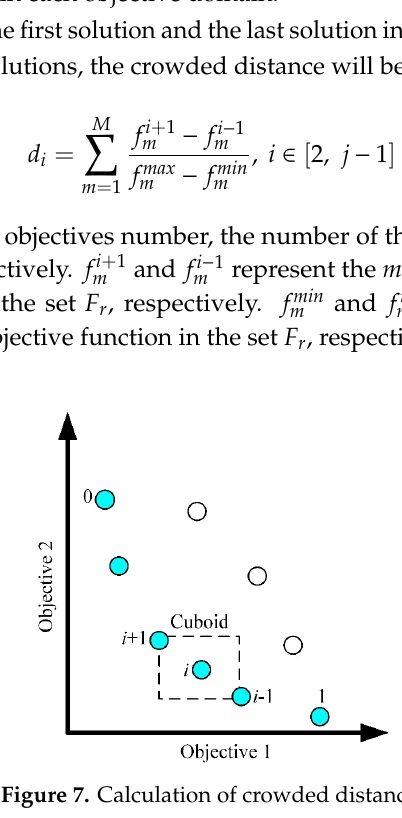
Figure 7. Calculation of crowded distance.